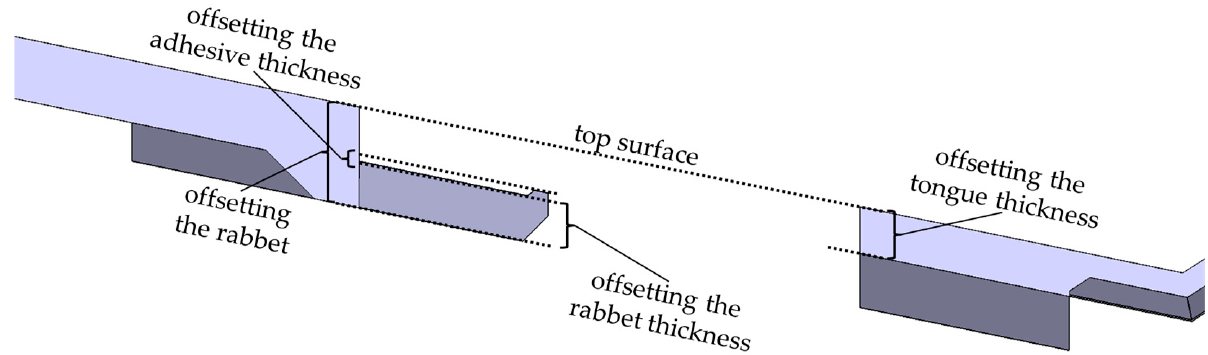
Figure 12. Areas of the rabbet and tongue formed by surface offsets.